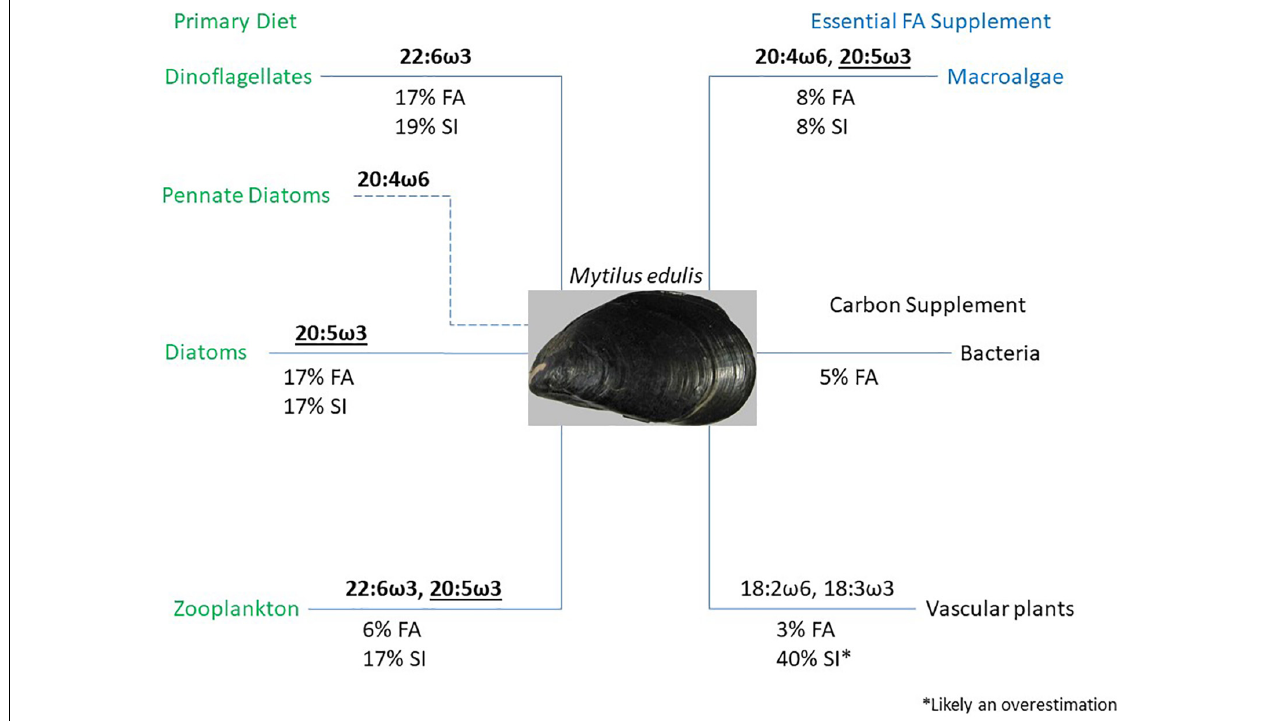
FIGURE 11 | Flowchart depicting the contributions of dinoflagellates, diatoms, zooplankton, macroalgal detritus, bacteria, and vascular plant detritus to the diet of Mytilus edulis . Contributions are shown based on measured fatty acid (FA) biomarkers and model estimates from stable isotope (SI) composition. Important FA contributions are also shown, bold indicates essential FA, underline denotes limiting FA, and ∗ denotes likely model overestimations.